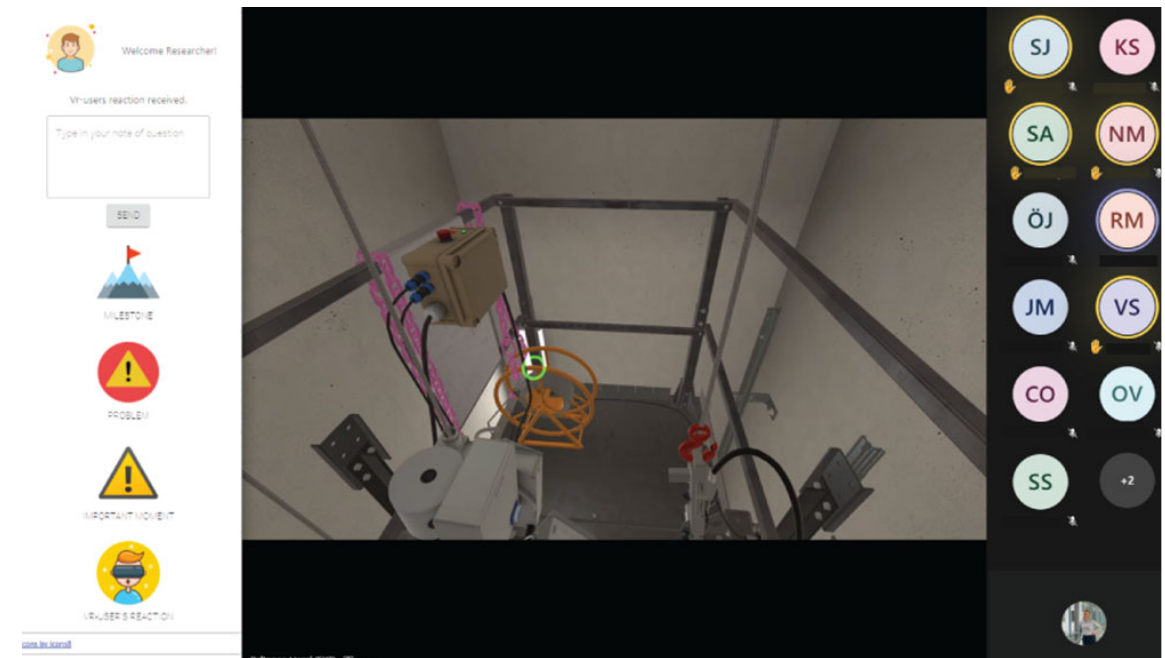
Figure 5. The screen of the observing researcher.